Question: Provide a one-line summary of what is displayed.
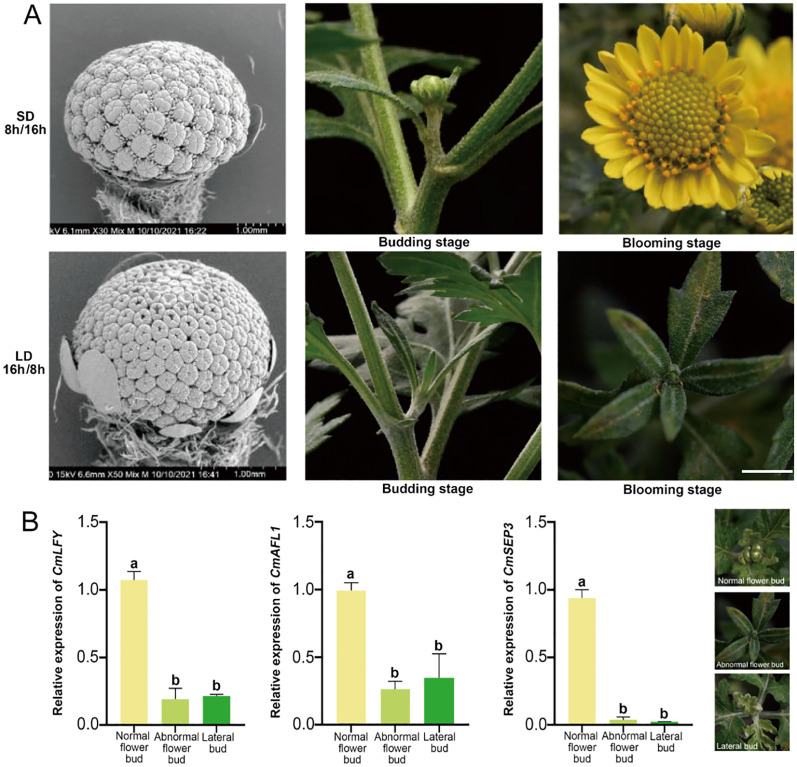
Answer: Developmentally arrested flower buds phenotype. (A) Developmentally arrested flower buds under short-day (SD) long-day (LD) and treatment. scale bar = 1 cm. (B) Expression of flowering-related genes in flower buds at different developmental stages.